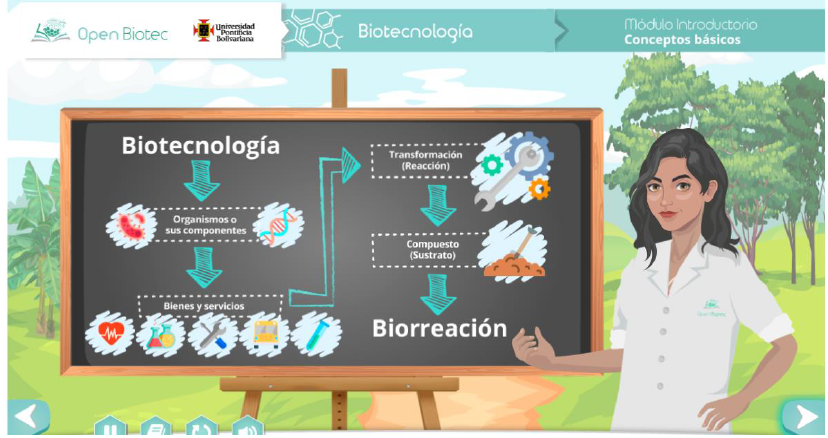
Figure 1. Screenshot of the environment for the introductory lesson, showing the controls, the avatars, and the content animations. Source: Screenshot of the course. URL: https://openbiotec.com (accessed on 17 February 2023). Table 3. Description of the Open Biotec MOOC